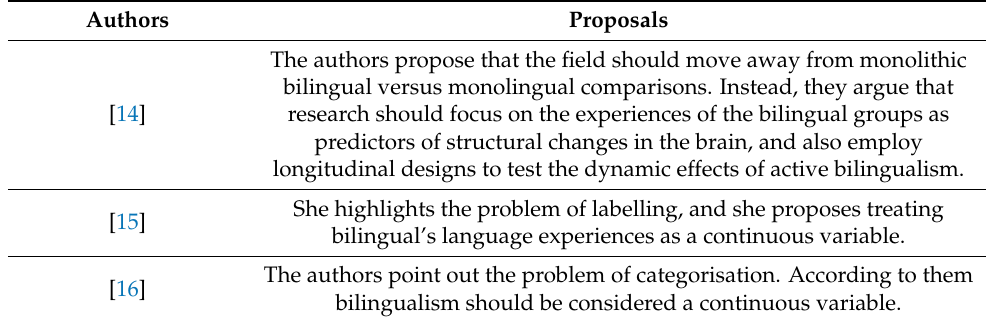
Table 1. Overview of the selected research studies with respect to individual variation in